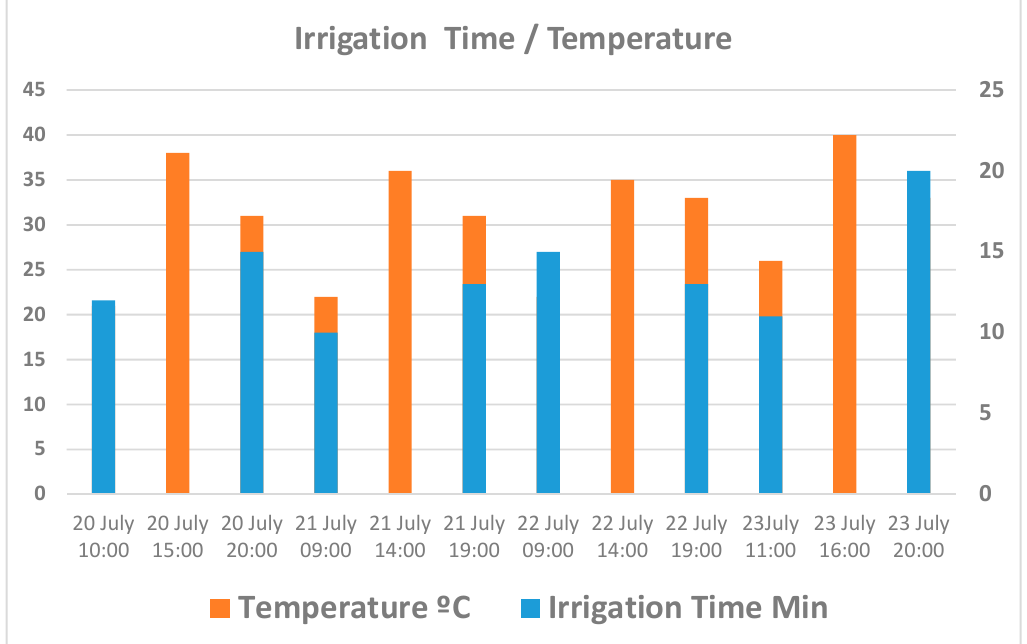
Figure 22. Relationship between the watering time and